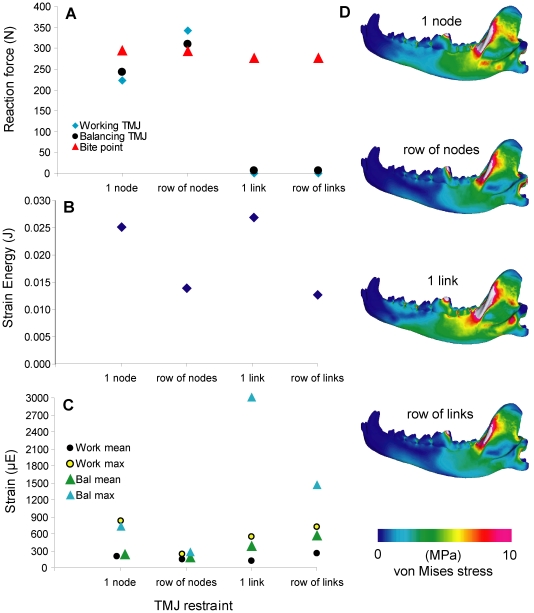
Sensitivity test on temporomandibular joint constraint.
A. Constraint type plotted against reaction force. B. Constraint type plotted against strain energy. C. Constraint type plotted against von Mises strain, showing mean and maximum strain for the working- and balancing-side joints, respectively. D. von Mises stress distribution in the working-side dentary in test models.